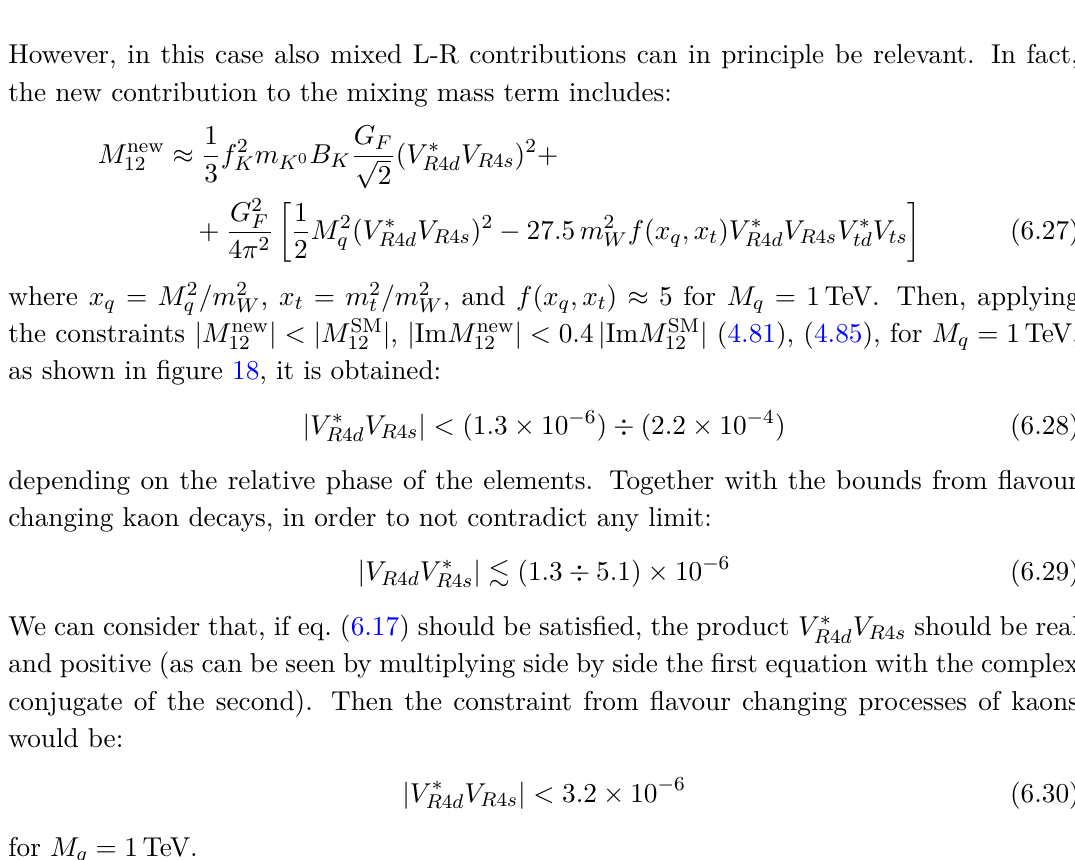
V R 4 d | from flavour changing kaon decays and neutral R 4 s , for the mass of the extra quarks M q = 1 R 21